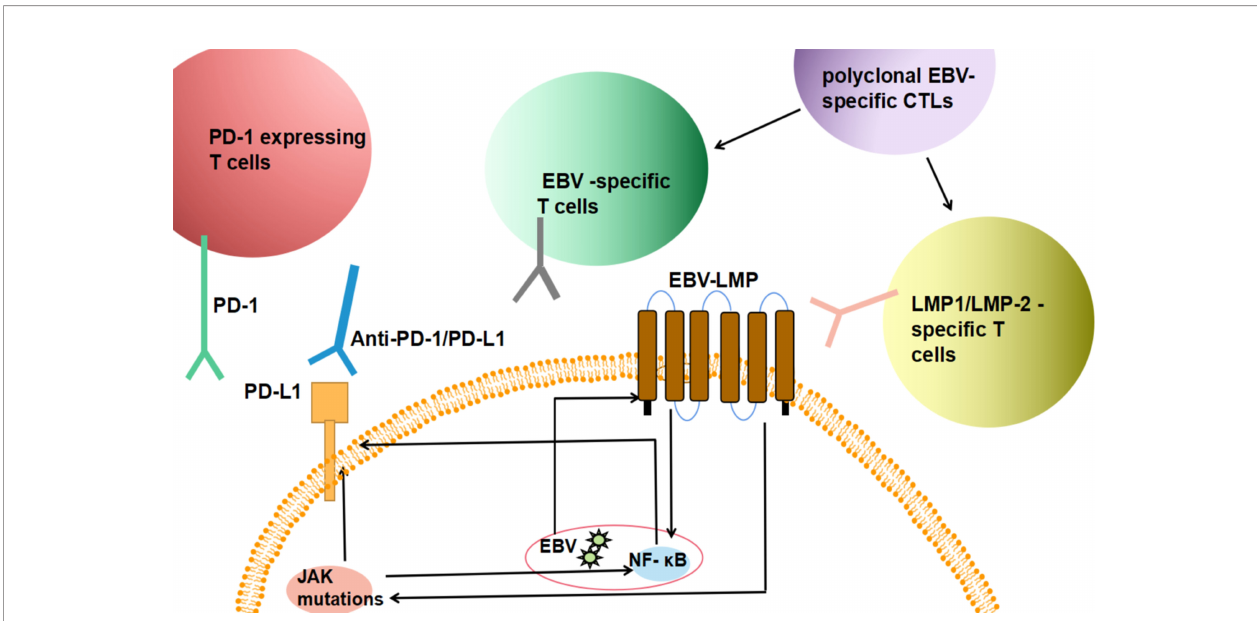
FIGURE 3 | Summary of the immunotherapeutic mechanism of EBV infected tumor cells. EBV infected tumor cells express PD-L1, and binding with PD-1- expressing T cells in microenvironment can inhibit immune killing function; EBV drives the overexpression of latent membrane protein LMP and the activates NF- k B/ MAPK and JAK/STAT signaling pathways lead to high expression of PD-L1. Therefore, after the infusion of polyclonal EBV speci fi c CTLs, the increased frequency of EBV and LMP speci fi c T cells and the application of PD-1/PD-1/L1 drugs can reduce immunosuppression and kill tumour